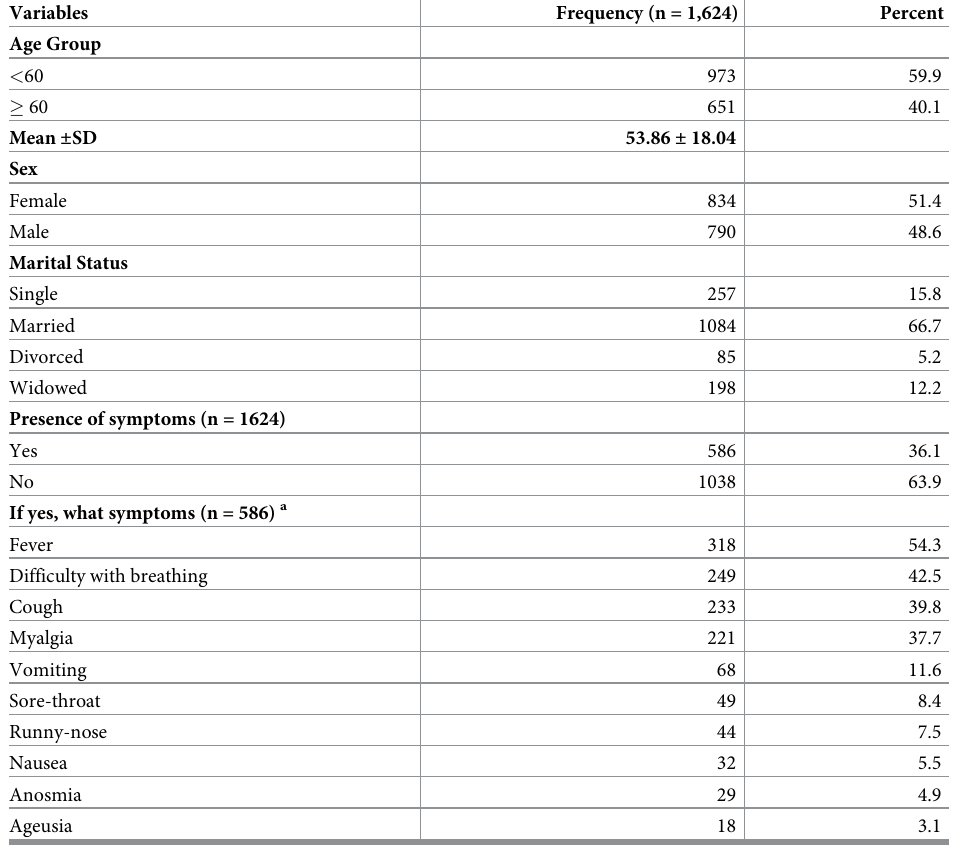
Table 1. Socio-demographic characteristics and symptom profile of